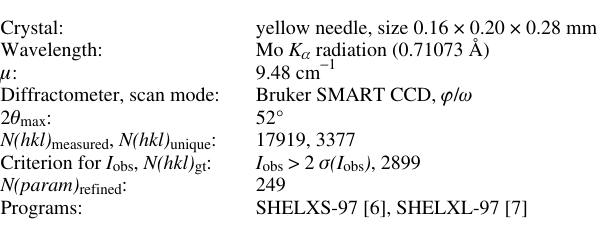
Table 1. Data collection and handling.